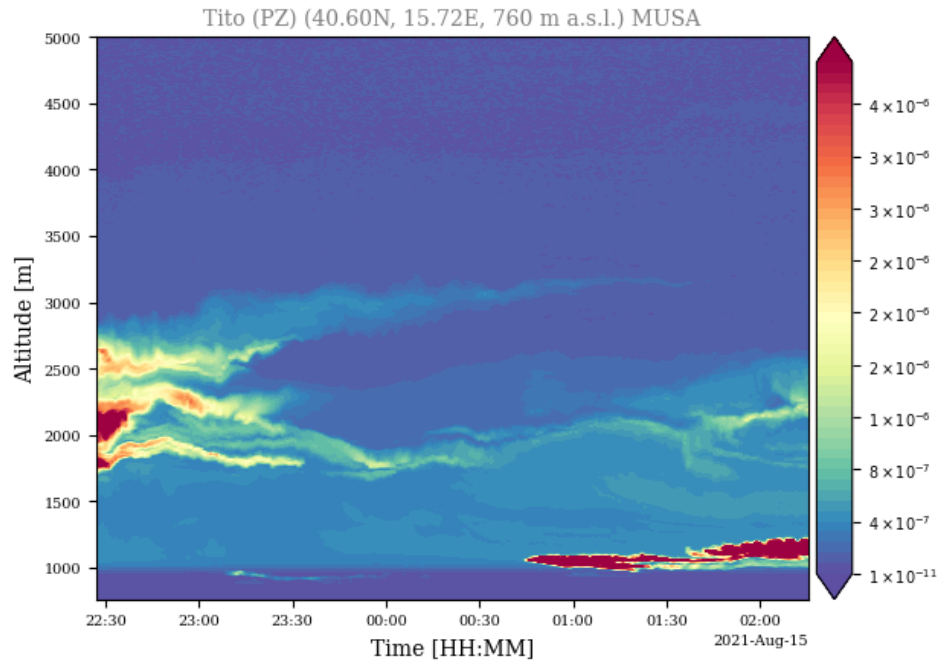
Figure 4. Temporal evolution of the attenuated backscatter coefficient at 1064 nm obtained with the MUSA lidar system on 14 August 2021 from 22:27 to 02:16 UTC.